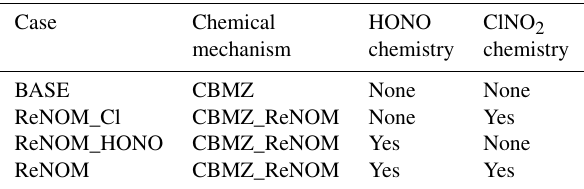
Table 3. Simulation cases of WRF-Chem